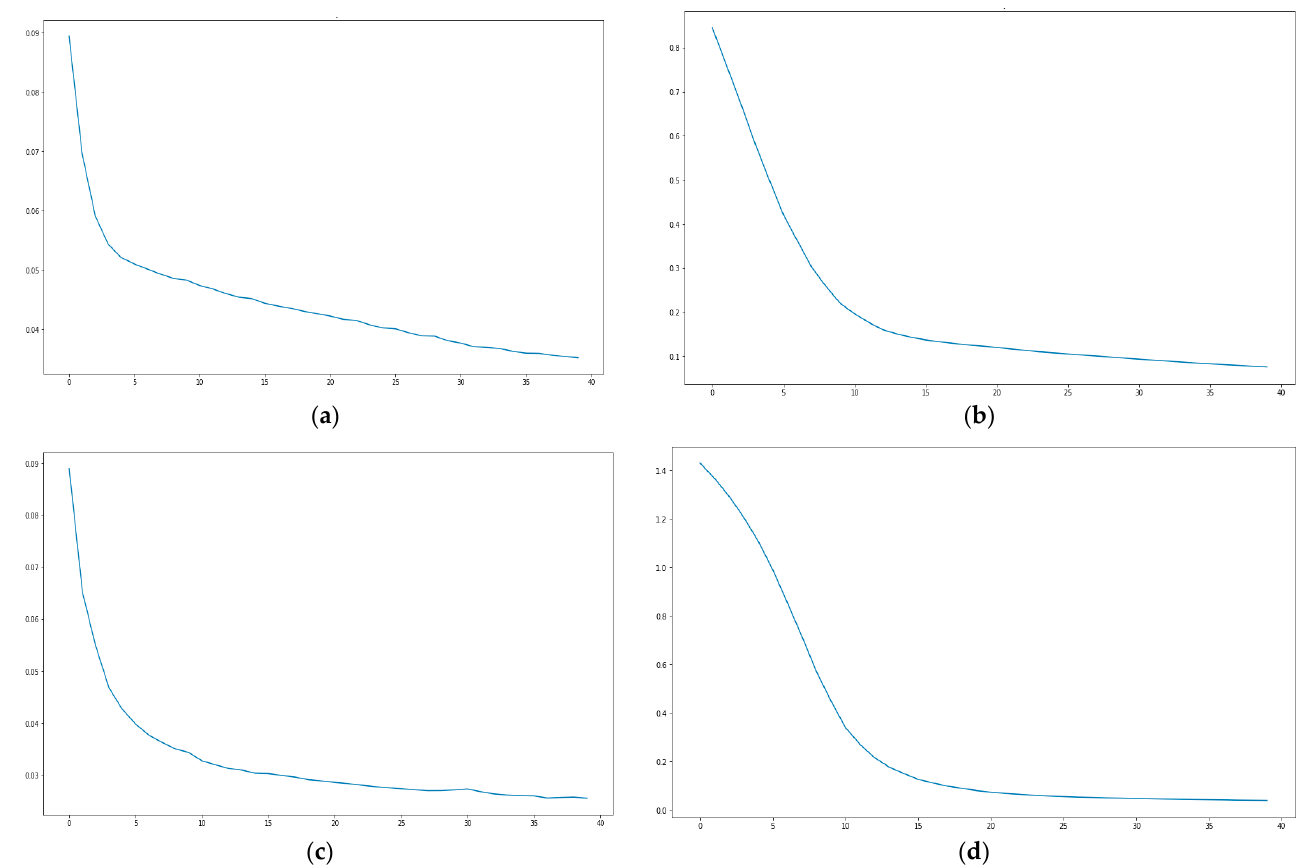
Figure 8. ( a ) Mean Square Error Scenario 1, ( b ) Mean Square Error Scenario 2, ( c ) Mean Square Error Scenario 3, ( d ) Mean Square Error Scenario 4.